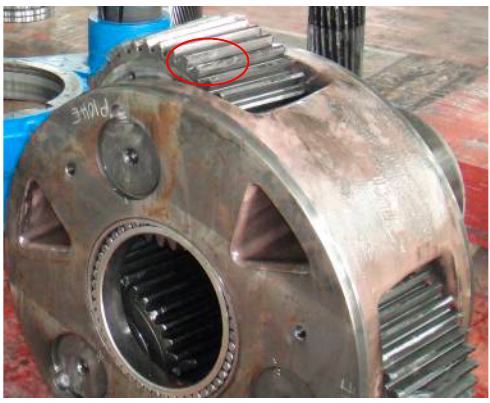
Figure 22. Chipped teeth of planet gear in a wind turbine gearbox.